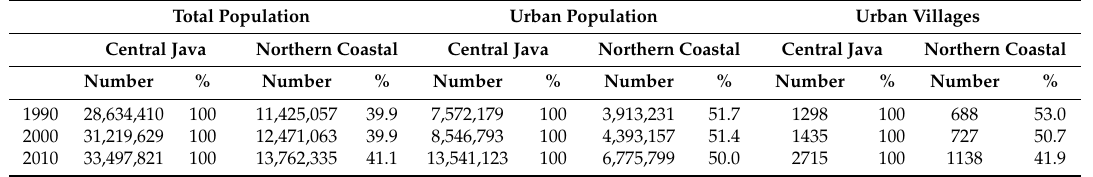
Table 5. Comparison of total population, urban population, and urban village in 1990, 2000, and 2010.